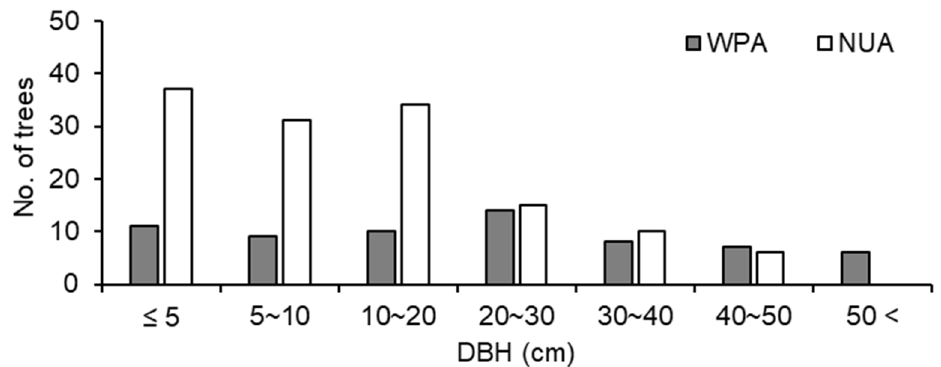
Figure 4. Tree size structure for all trees ≥ 1.5 m tall at a wildlife protected area (WPA) and the neighboring unprotected area (NUA) in 2011.